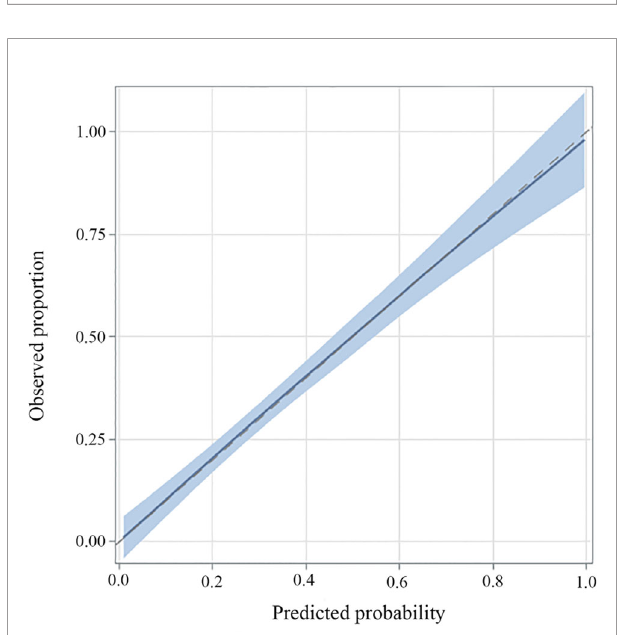
FIGURE 5 | Calibration plots of recalibrated prognostic models to predict risk of DLN metastasis. In the case of perfect calibration, all the groups of predicted probabilities fi t close to the blue diagonal line, corresponding to an intercept of 0 and a slope of 1 for the calibration plot. The vertical lines in grouped observations represent 95% con fi dence